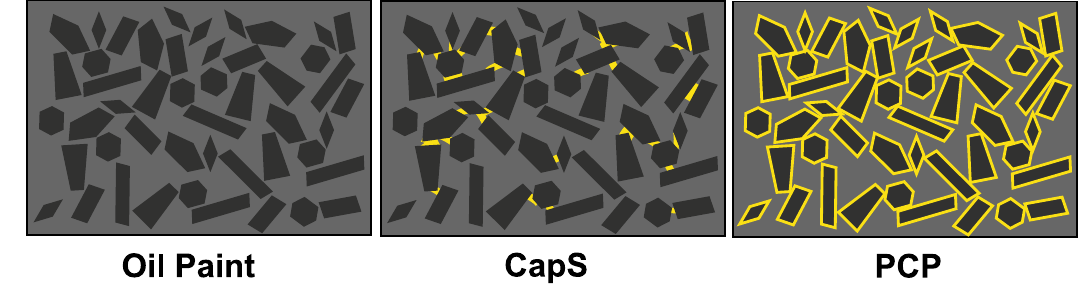
Fig. 2 | Proposed scheme of the paint model systems ’ microstructure. The pigments are represented in black; the oil is in gray and the egg yolk is in